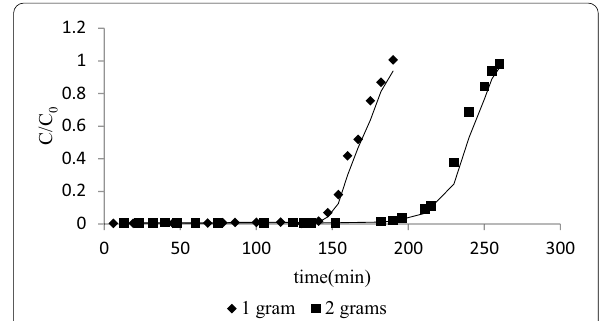
Fig. 13 Breakthrough curves obtained from column study of 1 g and 2 g SD beds